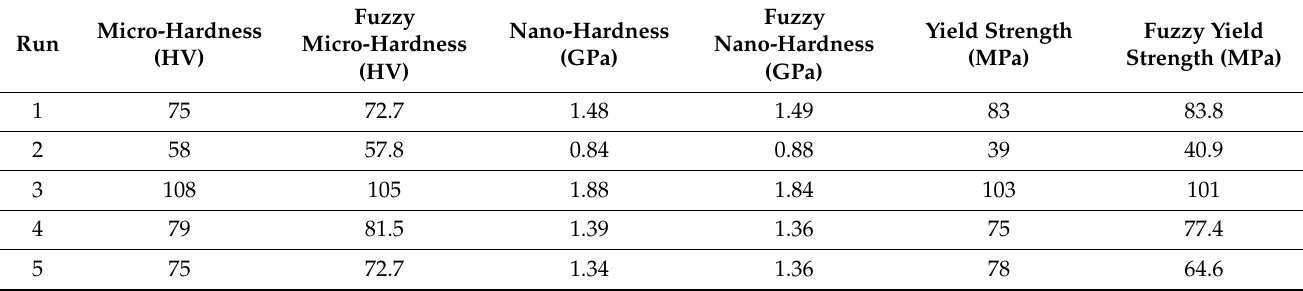
Figure 4. Yield strength and fuzzy yield strength results. Table 3. The experimental and fuzzy predicted results.